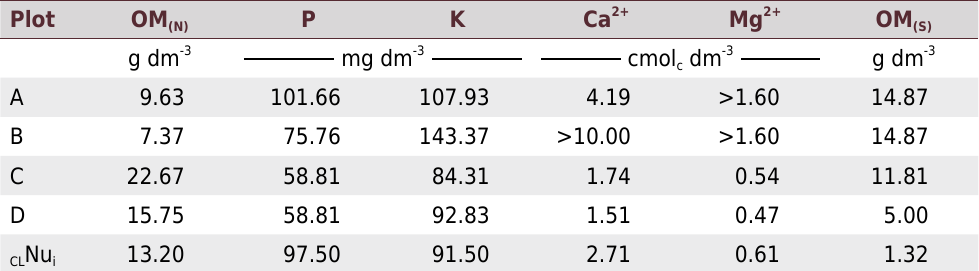
Table 7. Critical level of the contents of organic matter and phosphorus, potassium, calcium, and magnesium in the soil, estimated by leaf analysis, using models obtained by the Quadrant Diagram of the Plant-Soil Relationship (QDpsR) method